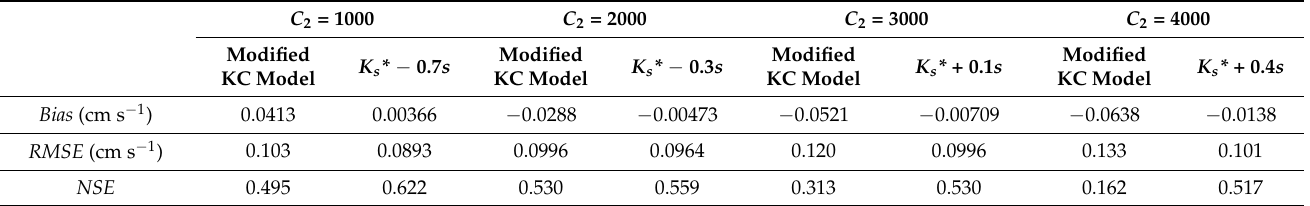
Table 1. Comparison of statistical measures between the modified KC model in [12] and the present